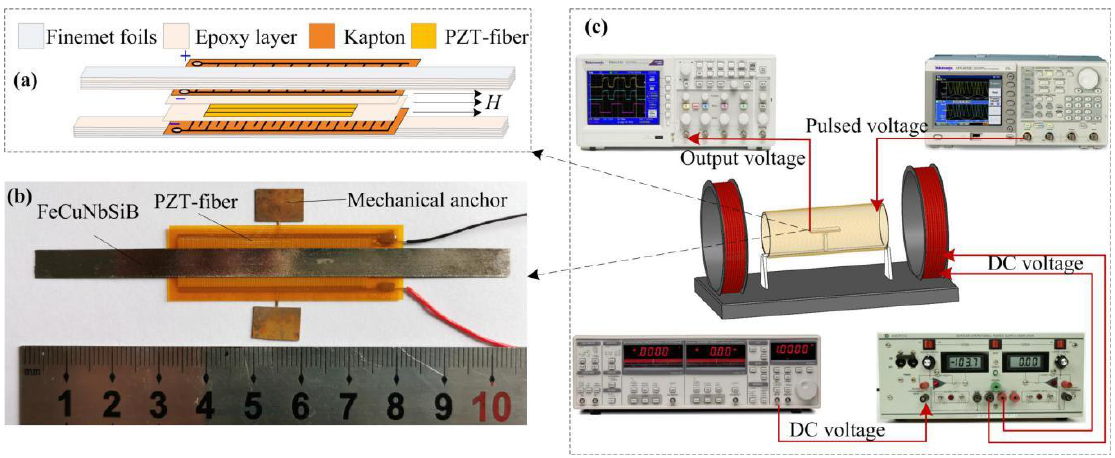
Figure 1. ( a ) Schematic illustrations of the FeCuNbSiB / piezofiber magnetoelectric (ME) composites, ( b ) photograph of the FeCuNbSiB / piezofiber ME composites, ( c ) schematic illustrations of the ( b ) photograph of the FeCuNbSiB/piezofiber ME composites, ( c ) schematic illustrations of the experimental experimental setup.